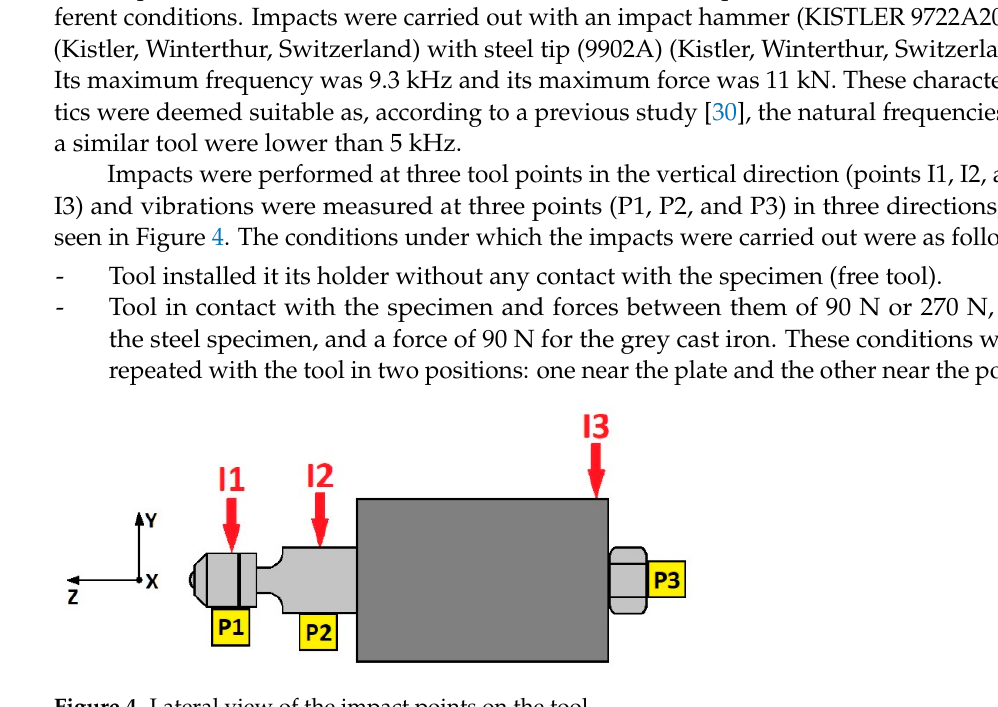
Figure 4. Lateral view of the impact points on the tool.